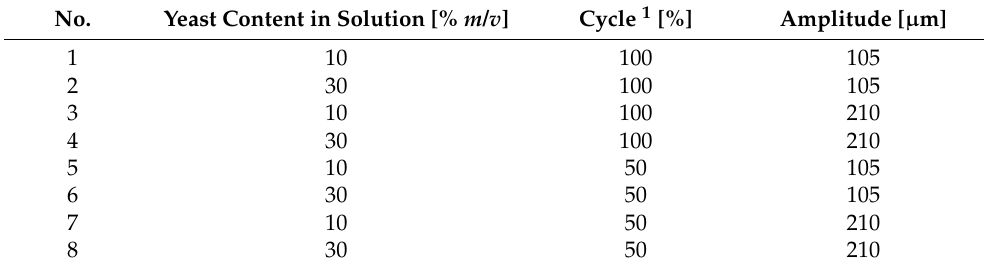
Table 1. Parameters of